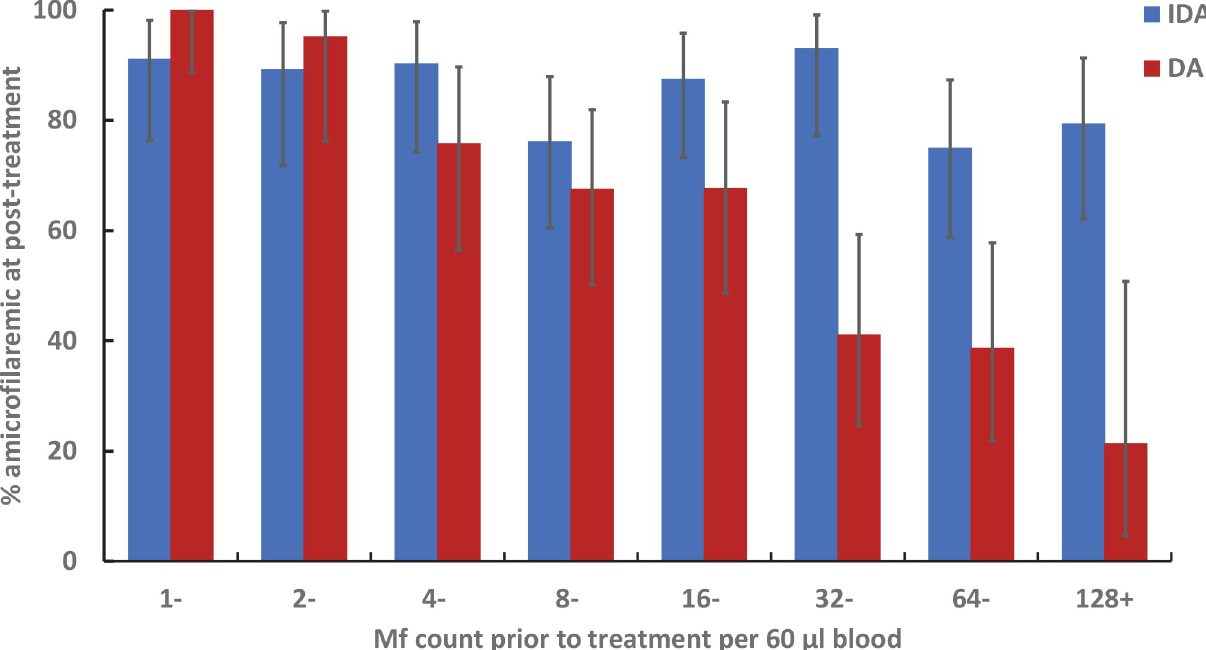
Fig 6. Distribution of subjects who were amicrofilaremic 1 year after treatment by pre-treatment microfilaria count. Error bars 95% CI based on exact binomial probability distribution.